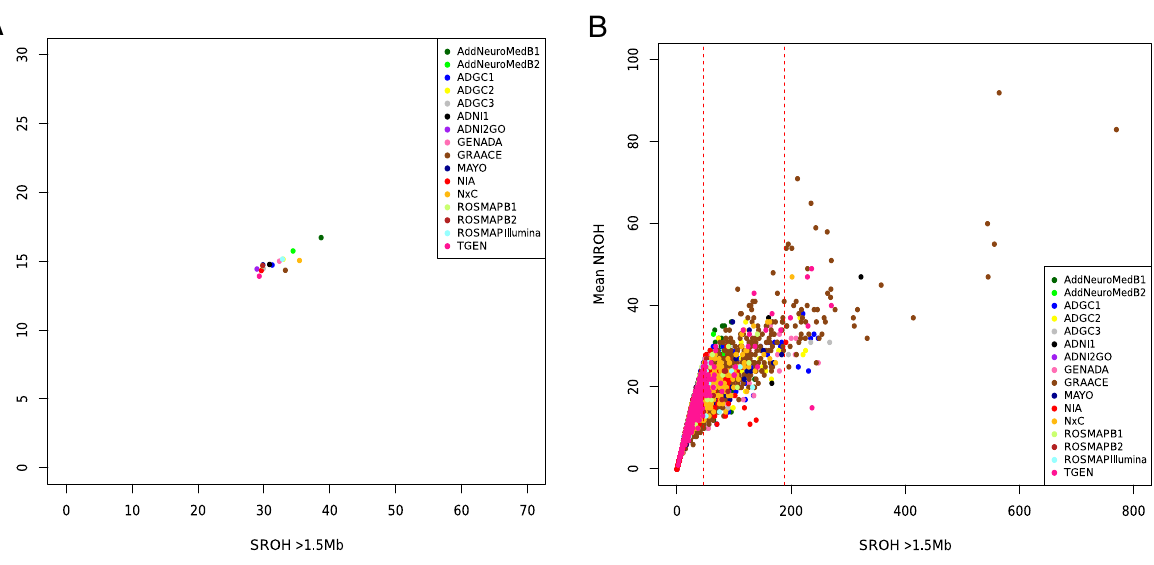
Fig. 2 Runs of homozygosity per cohort and per individual. A Mean number of ROHs versus mean total sum of ROHs in Mb for the 10 cohorts explored. B Mean number of ROHs versus mean total sum of ROHs in Mb per individual explored. Red dashed lines represent the threshold for the inbreeding coef fi cient of 0.0156 (second cousins ’ offspring) and 0.0625 ( fi rst cousins ’